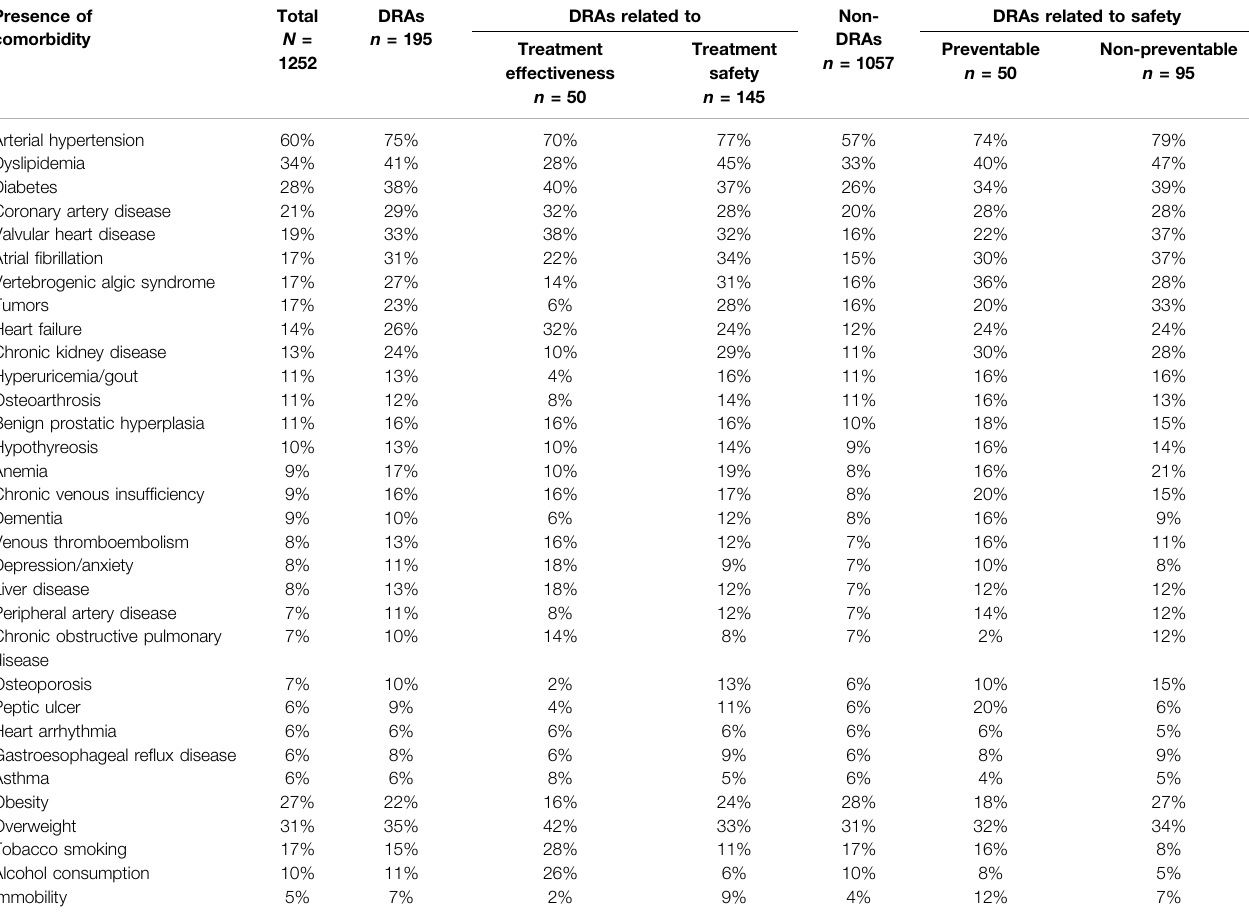
TABLE 2 | Comorbidities of the study sample and inter-group differences. Presence of